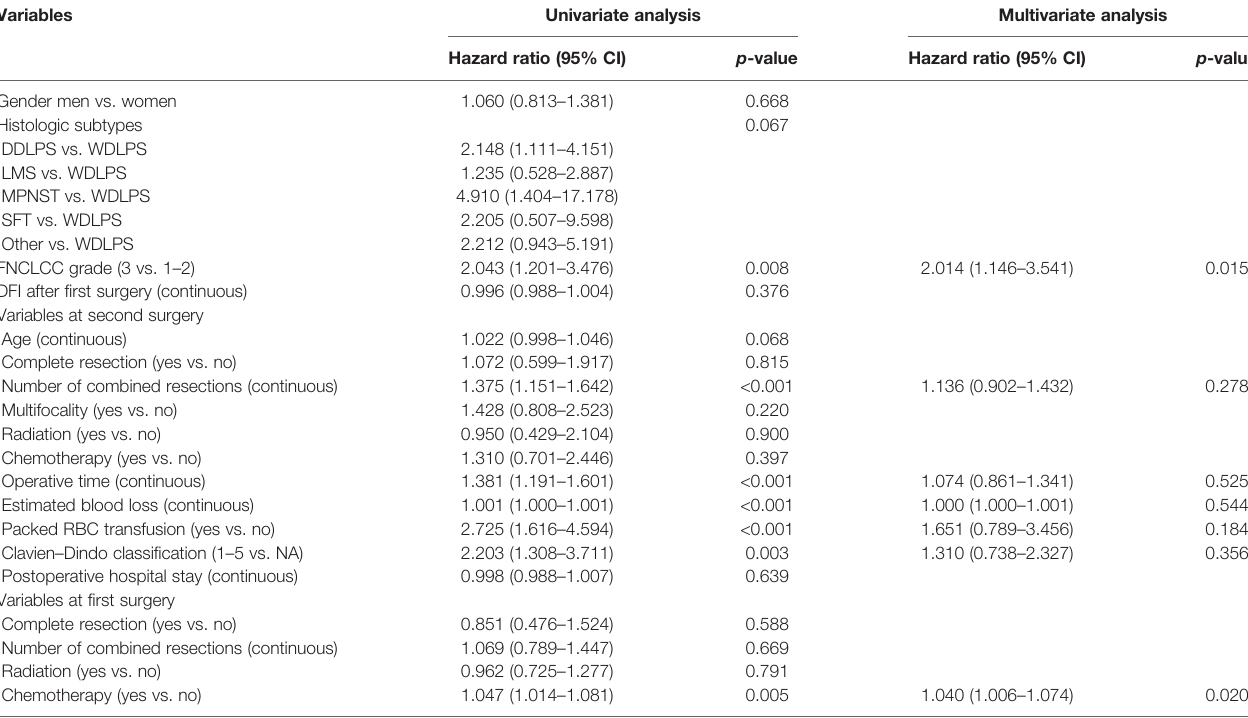
TABLE 4 | Univariable and multivariable analyses to determine the independent predictors of overall